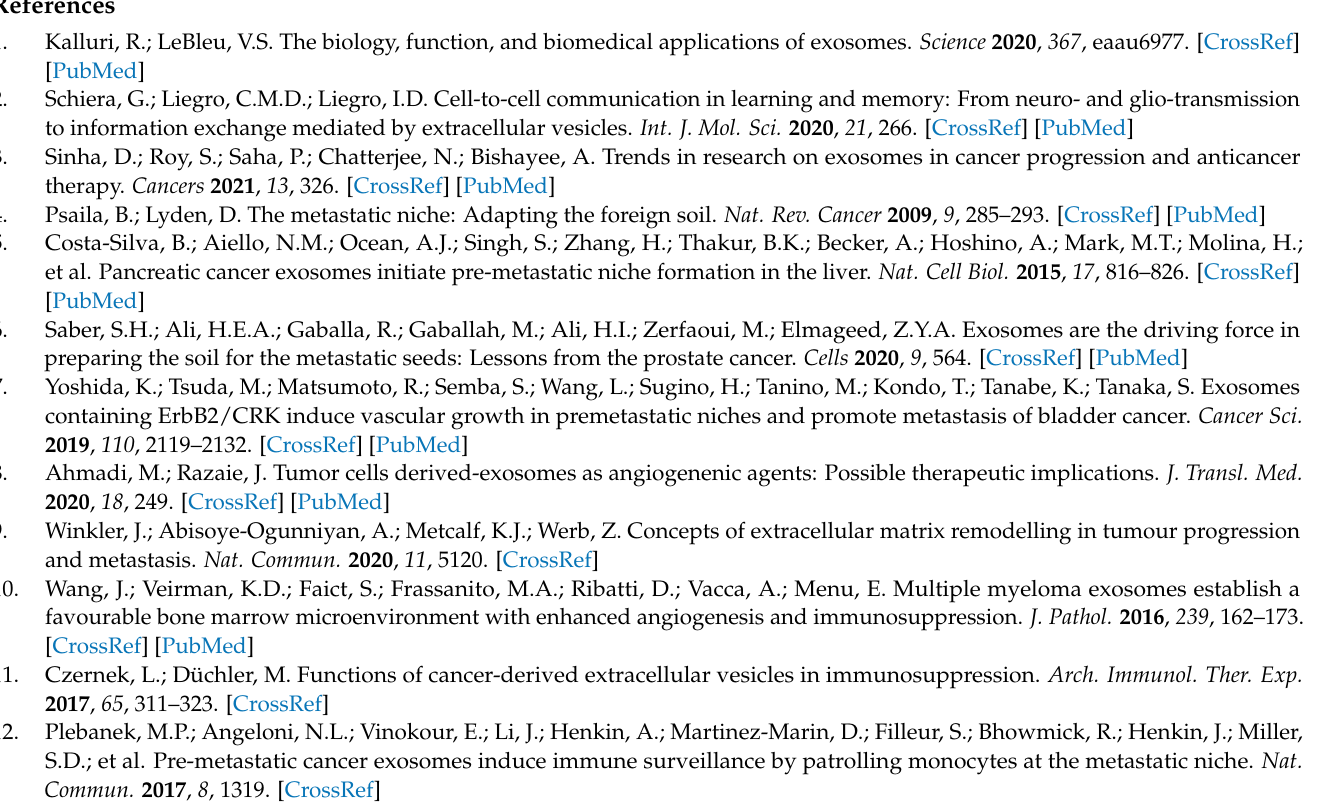
data of Figure 1A. Figure S2. Examples of metastatic colonies found in Lung and kidney caused by F10 administration. Scale bar: 5 mm. Figure S3. Determination of the volume of metastatic colony. (A) A photograph of liver. A blue triangle indicates a metastatic colony of Nanog + F10. Bar indicates 5 mm. (B) The shape of each colony was approximated as a spheroid and the following formula was used: V = (1/6) π ab 2 , where a and b (= c ) were the longest and shortest diameters, respectively. Figure S4. Full-length gel images for the data of Figure 2A. Table S1. Primers used for